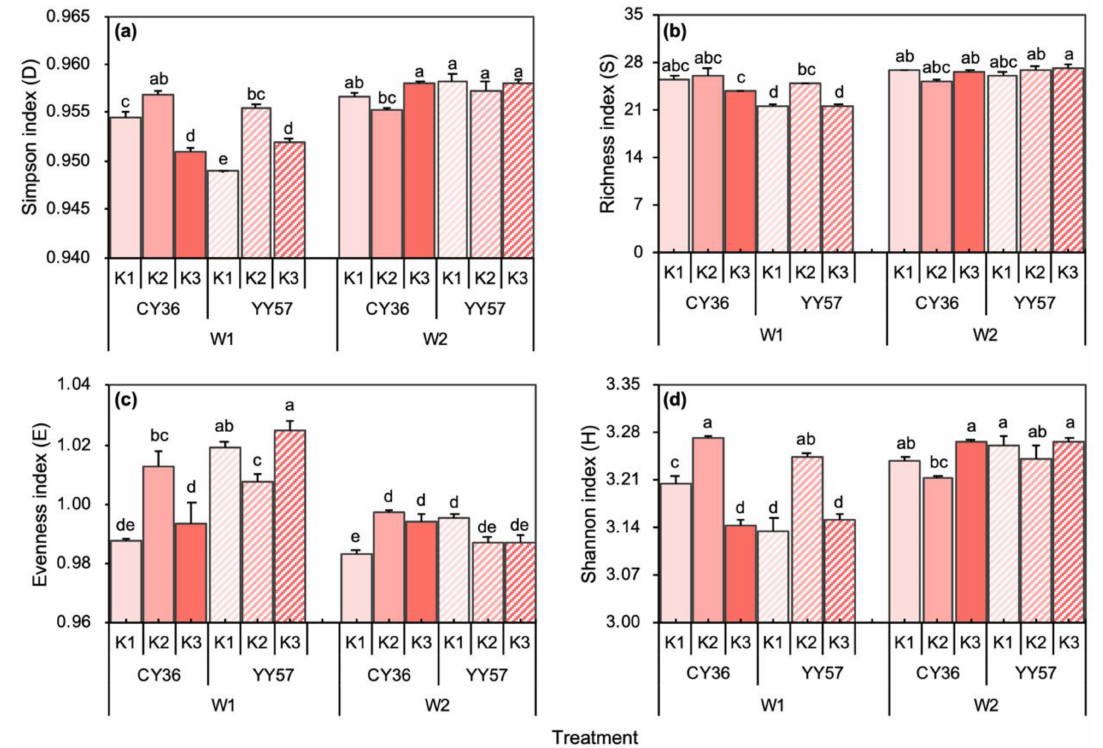
Figure 6. Effects of K supply level on the rhizosphere microbial diversity index under different soil moisture content: ( a ) Simpson index ( D ), ( b ) richness index ( S ), ( c ) evenness index ( E ), ( d ) Shannon index ( H ) of two rapeseed cultivars. W1 and W2 indicate 40% and 75% water-holding capacity, respectively, and K1, K2, and K3 indicate K (K 2 O) applications rates 0, 80 and 160 mg · kg − 1 , respectively. Means and standard errors ( n = 4). Different small letters mean significant differences in Duncan multiple range tests among different treatments at 5% level ( p < 0.05).